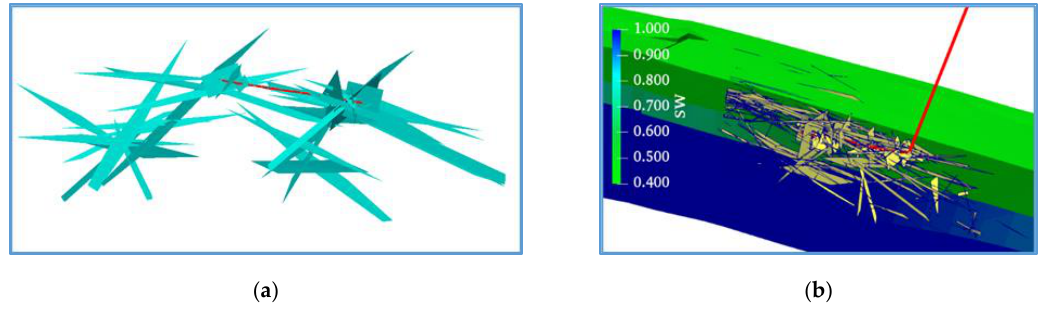
Figure 32. Six shortest fracture paths from well B4 to the water contact: ( a ) 3D visualization of the fractures paths along the wellbore; ( b ) shortest fractures planes embedding the grid blocks which display a vertical intersection 3D view of the water saturation of the matrix.